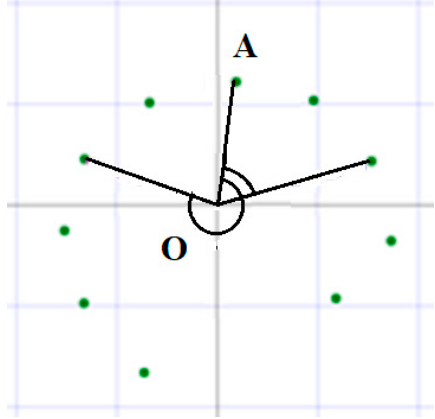
Figure 3. Selection of points while sorting.